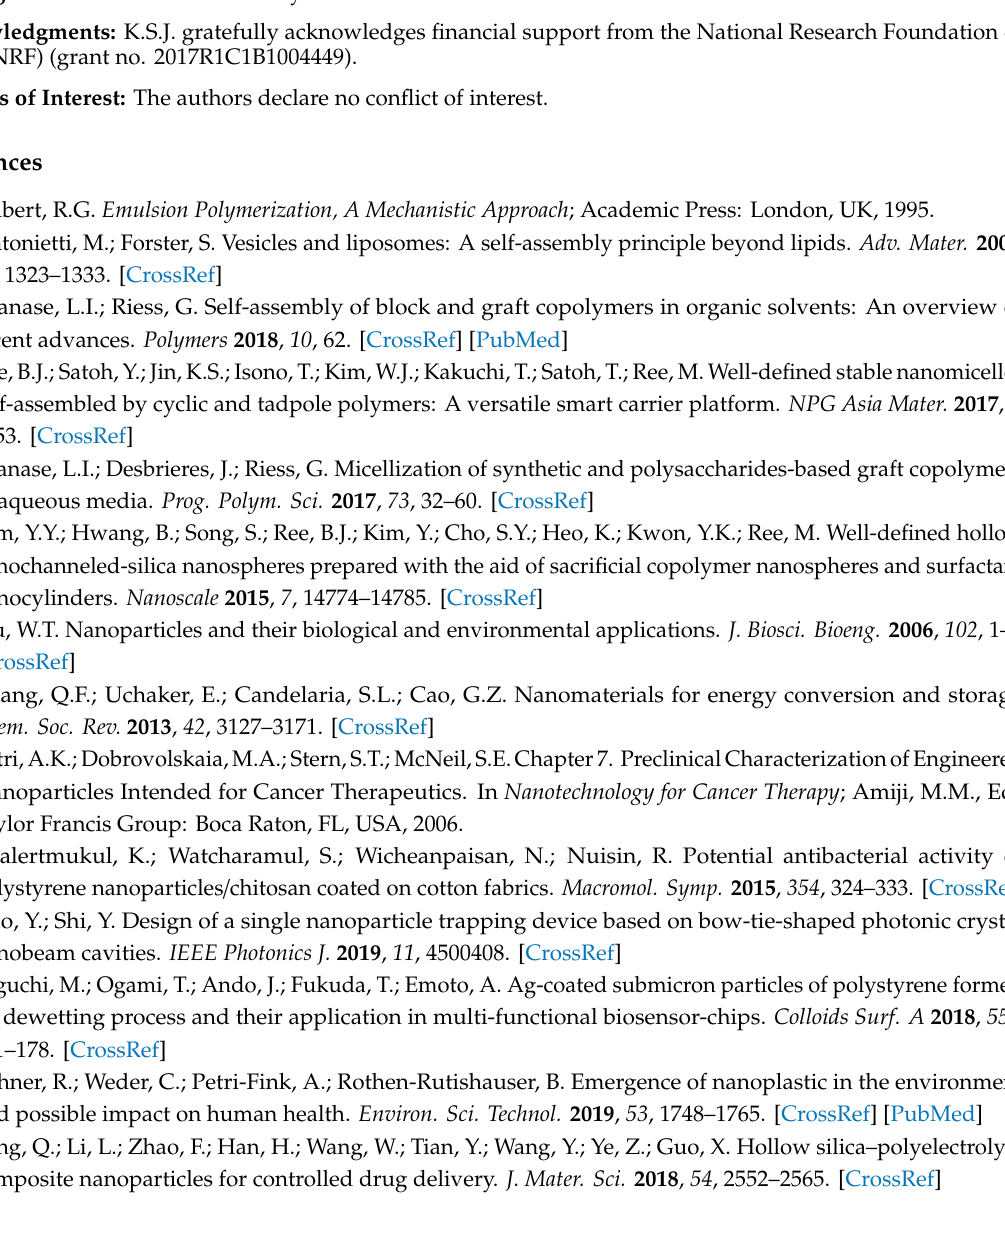
Figure S1: Pair distance distribution functions p ( r ) obtained from numerical Fourier transformation of the extrapolated scattering intensity profile from model analysis, Table S1: Structural parameters of PS nanoparticles determined from p(r) function obtained by numerical Fourier transformation of respective extrapolated scattering intensity profile acquired in the quantitative structural model